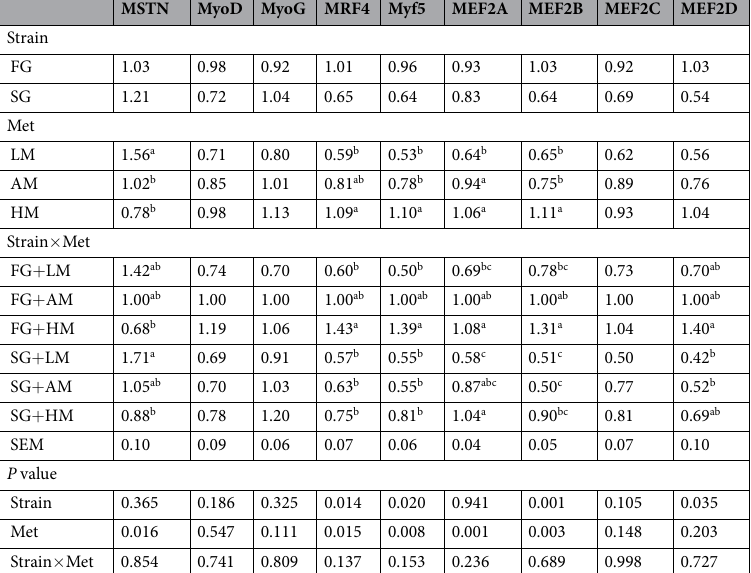
Table 3. Effects of dietary methionine on relative mRNA levels in breast muscle of broilers at 42 d of age. Results are presented as means and pooled SEM (n = 6). Mean values within a column with unlike superscript letters were significantly different ( P <